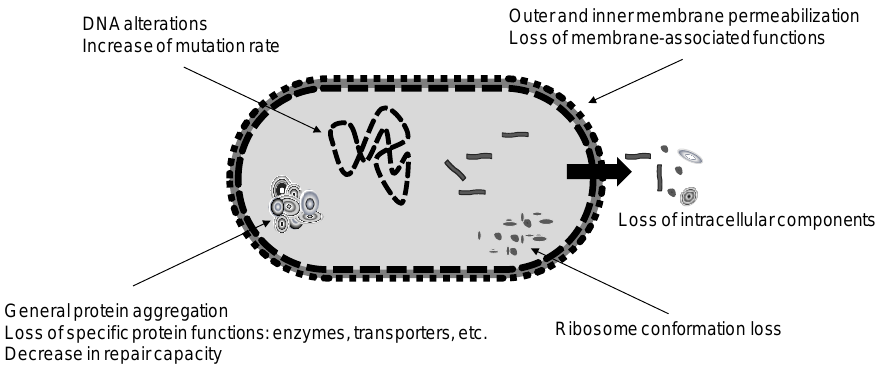
Figure 2. Summary of the most relevant cellular events that occur in a vegetative bacterial cell upon exposure to heat.